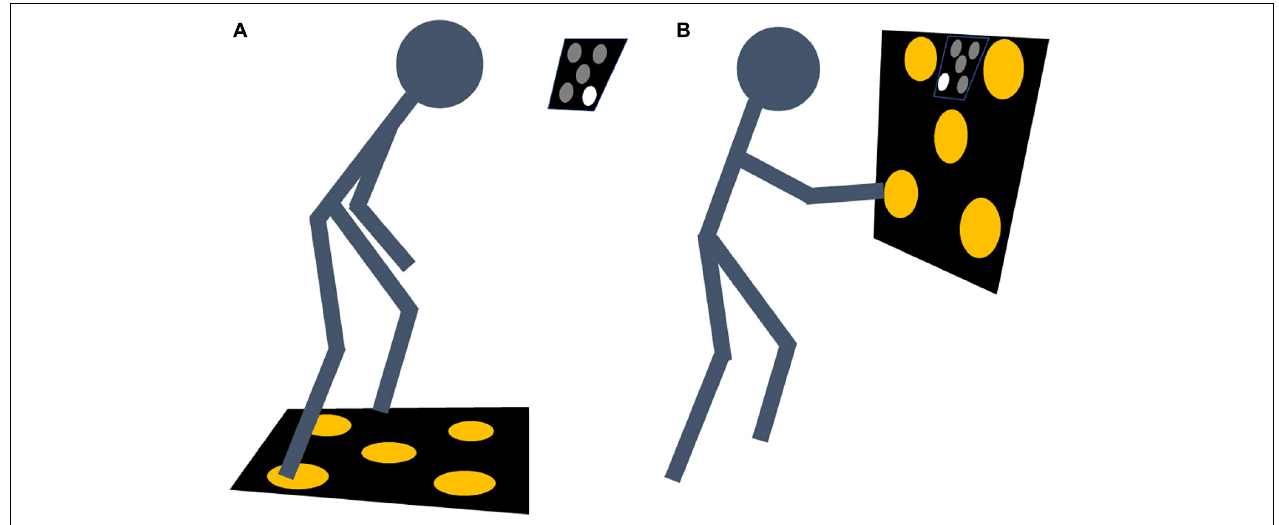
FIGURE 1 | Setup for the open skill visuomotor reaction drill of the lower (A) and upper (B)